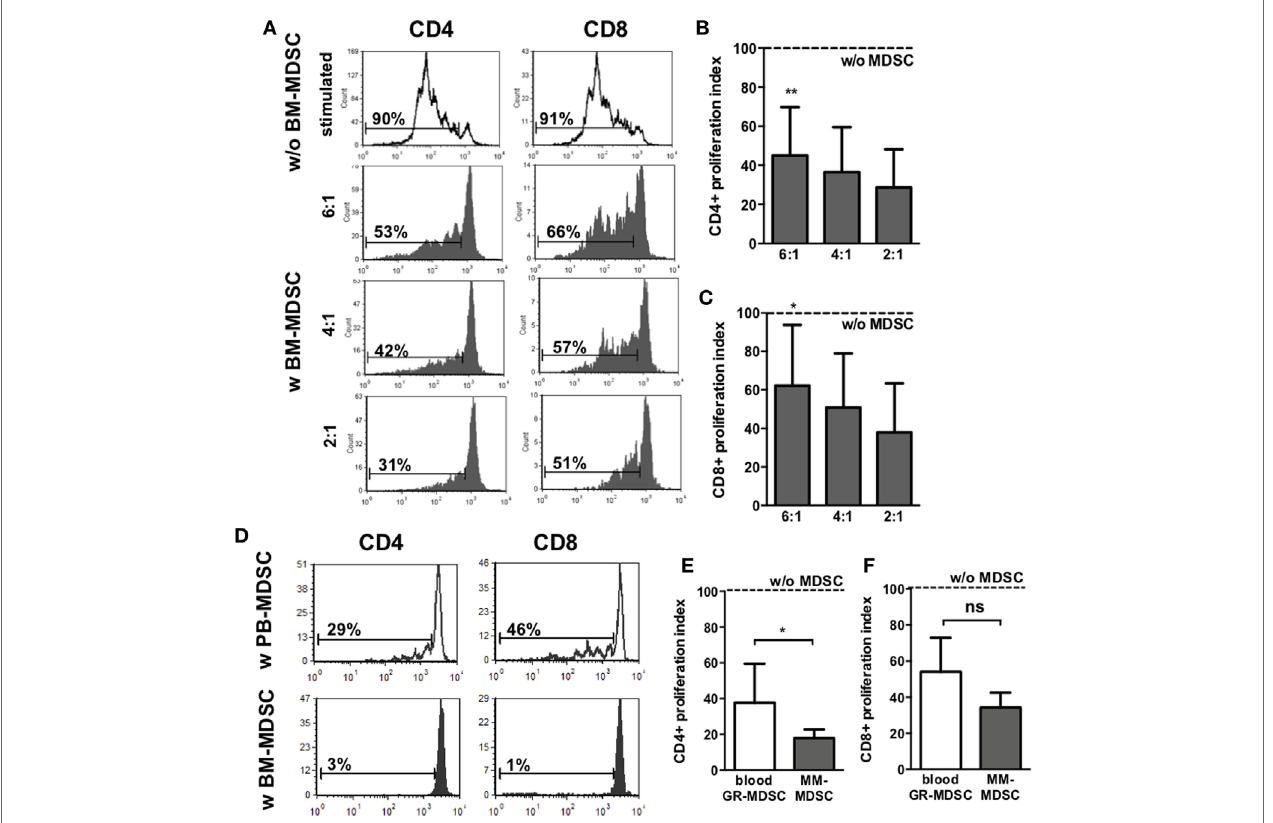
FigUre 2 | Inhibiton of CD4 + and CD8 + T-cell proliferation by granulocytic MDSC (GR-MDSC) from breast milk (BM). GR-MDSC were enriched from BM (BM- MDSC) and added to carboxyfluorescein-succinimidyl ester (CFSE)-stained and IL-2/OKT3-stimulated peripheral blood mononuclear cell (PBMC) isolated from a healthy adult control. After 4 days, proliferation of CD4 + and CD8 + T-cells was assessed by CFSE dye dilution. Proliferation index was determined as ratio of T-cell proliferation with and without addition of BM-MDSC. (a) Representative histogram plots showing proliferation of CD4 + T-cells and CD8 + T-cells with (gray histograms) and without (white histograms) addition of BM-MDSC in different proportions (ratio PBMC:BM-MDSC 6:1, 4:1, and 2:1). (B,c) Inhibitory effect of BM-MDSC on proliferation of CD4 + (B) and CD8 + T-cells (c) . Dashed line shows proliferation of target PBMC without addition of BM-MDSC. Inhibition of T-cell proliferation by BM-MDSC was measured at the indicated ratios by CFSE dye dilution. Bars show mean and SD of seven samples pooled from seven independent experiments. * p < 0.05, ** p < 0.01 compared with target cells alone; Wilcoxon matched-pairs signed-rank test. (D) Representative histogram plots (from five independent experiments) showing proliferation of CD4 + T-cells and CD8 + T-cells after stimulation with OKT3 and IL-2 and addition of GR-MDSC isolated from PBMC from peripheral blood (white histograms) and BM-MDSC of the same person (gray histograms) in a 2:1 ratio. (e,F) The inhibitory effect of GR-MDSC from peripheral blood (blood GR-MDSC, white bars) and from BM (BM-MDSC, gray bars) on proliferation of CD4 + (e) and CD8 + T-cells (F) were assessed. Dashed line shows proliferation of target PBMC without addition of GR-MDSC. Inhibition of T-cell proliferation by GR-MDSC was measured at the indicated ratios by CFSE dye dilution. Bars show mean and SD of five independent experiments. * p < 0.05; ns not significant; Wilcoxon matched-pairs signed-rank